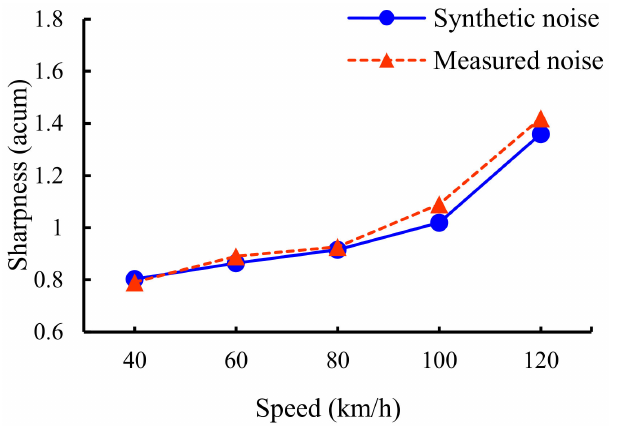
Figure 23. Comparison of synthetic and measured noise sharpness at different operating speeds of the PEV.